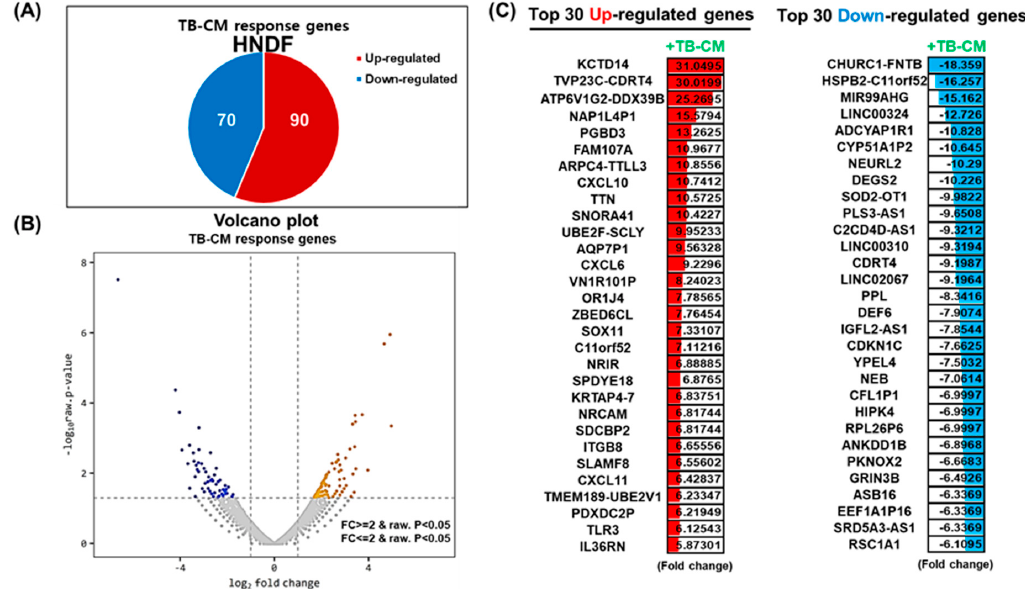
Figure 5. TB-CM induced widespread transcriptome alteration in HNDF cells during migration. ( A ) Scratch-wounded HNDF cells were treated with 20% TB-CM, following which RNA-seq was performed to identify the DEGs upon the treatment of HNDFs with TB-CM. The number of up- and downregulated genes in response to TB-CM treatment of HNDF cells is indicated ( p < 0.05). ( B ) The distribution of significant DEGs is visualized in the form of a Volcano plot, which analyzed statistical significance versus fold change. ( C ) The top 30 up- and downregulated genes in TB-CM-treated HNDFs are represented by means of color images and value of fold change (fold difference with p < 0.05). The color depicts the levels of fold change.